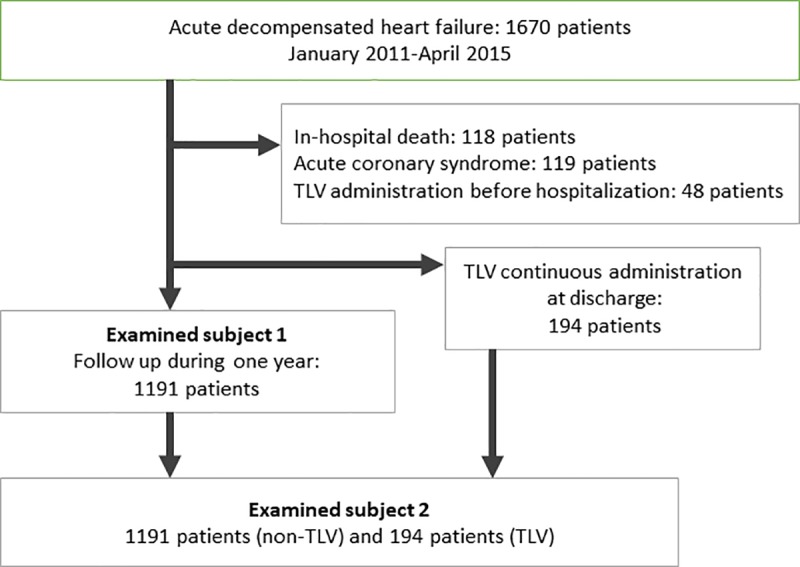
Patient flow chart of the present study.Examined subject 1 included a total of 1191 patients to investigate the risk heart failure-related re-hospitalization. Examined subject 2 investigated the effect of continuous administration of Tolvaptan (TLV), and included the 1191 patients from examined subject 1, as well as the patients who received continuous administration of TLV when they were discharged from the hospital (n = 194).